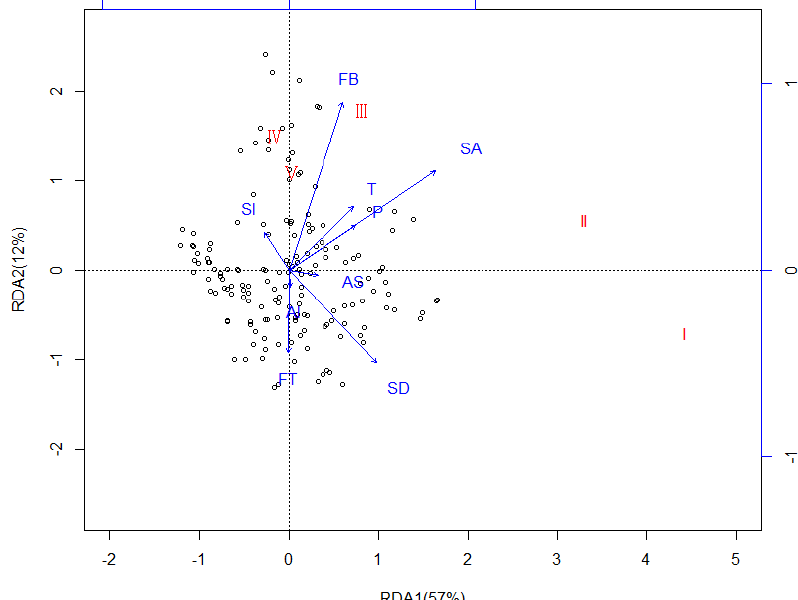
Figure 10. Redundancy Analysis (RDA) showing the relationships between the CWD decay classes and effect factors in the different samples on the Huoditang Experimental Forest Farm in the Qinling Mountains (China). Arrows indicate effect factors: FT = Forest type; FB = Forest biomass; AS = Aspect; Al = Altitude; SA = Stand age; Sl = Slope; SD = Stand density; T = Annual average temperature; P = Annual average precipitation. CWD decay class names in red indicate the decay stage’s vector endpoints. The numbers I–V represent different decomposition stages where I represents the initial stage and V represents the final